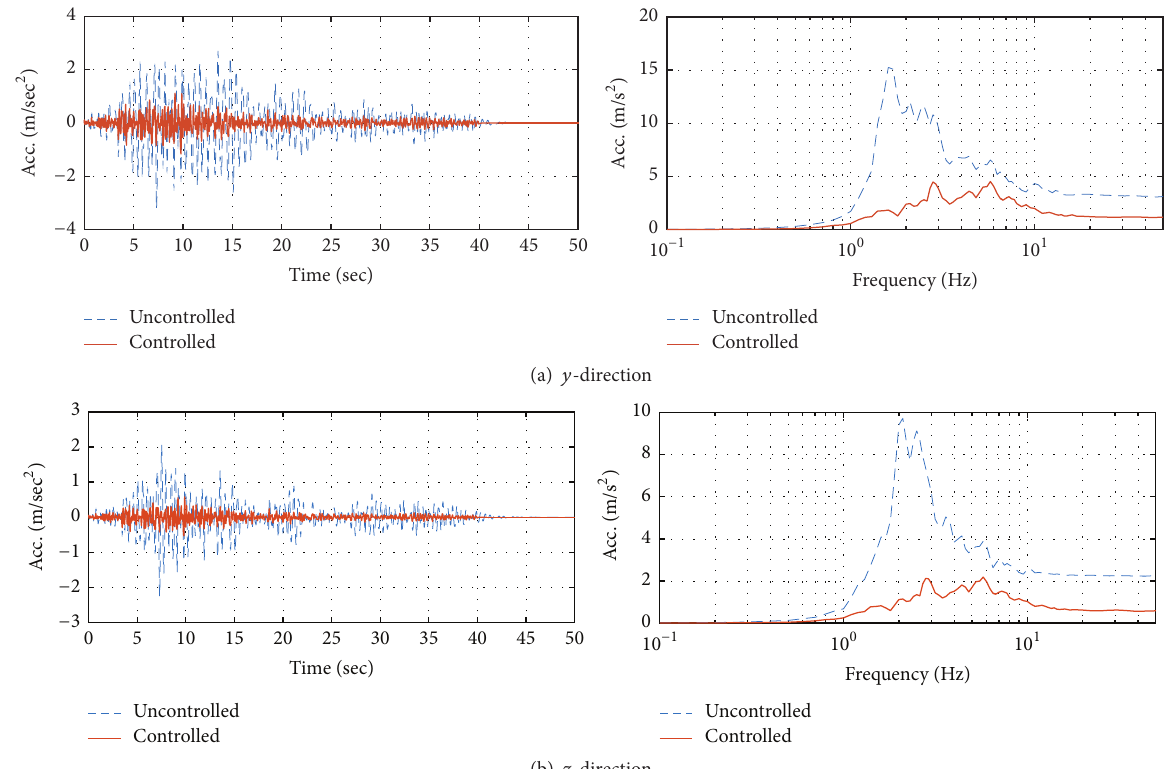
Figure 15: Response of piping system subjected to California